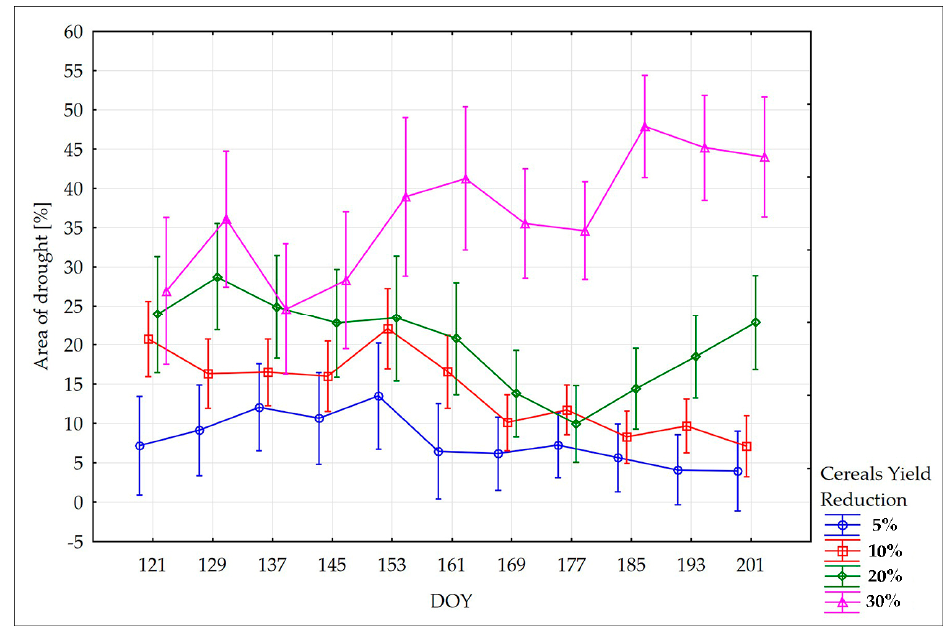
Figure 12. Multi-way analysis of variance (ANOVA) in groups of yield reduction for cereals.